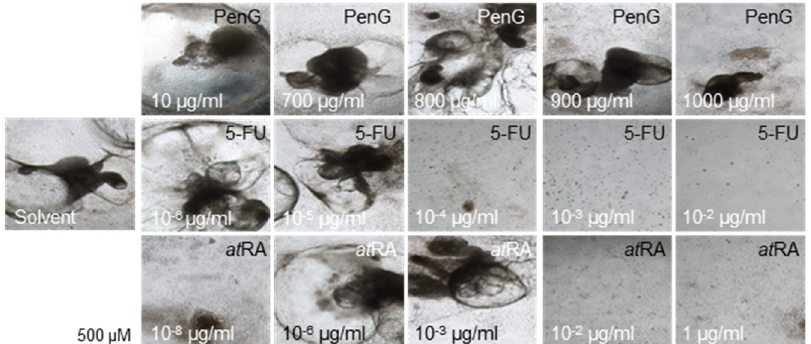
Figure 2. Presence of contractile cardiomyocyte clusters declines with treatment with embryotoxi- cants 5-FU and at RA. hiPSCs were treated with different concentrations of 5-FU, at RA, or PenG and photographed. hiPSC, human induced pluripotent stem cell; 5-FU, 5-fluorouracil; at RA, all-trans retinoic acid; PenG, penicillin G.